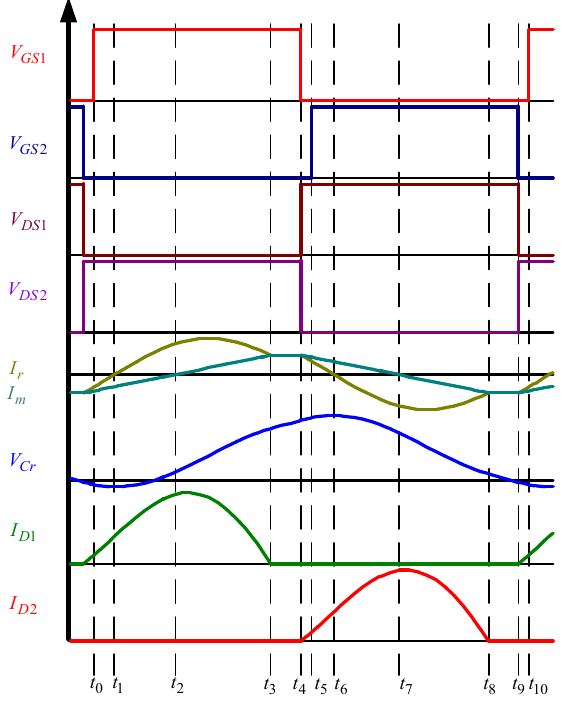
Figure 7. Schematic diagram of LLC resonant converter operated in the mode of Region 2 (ZVS).